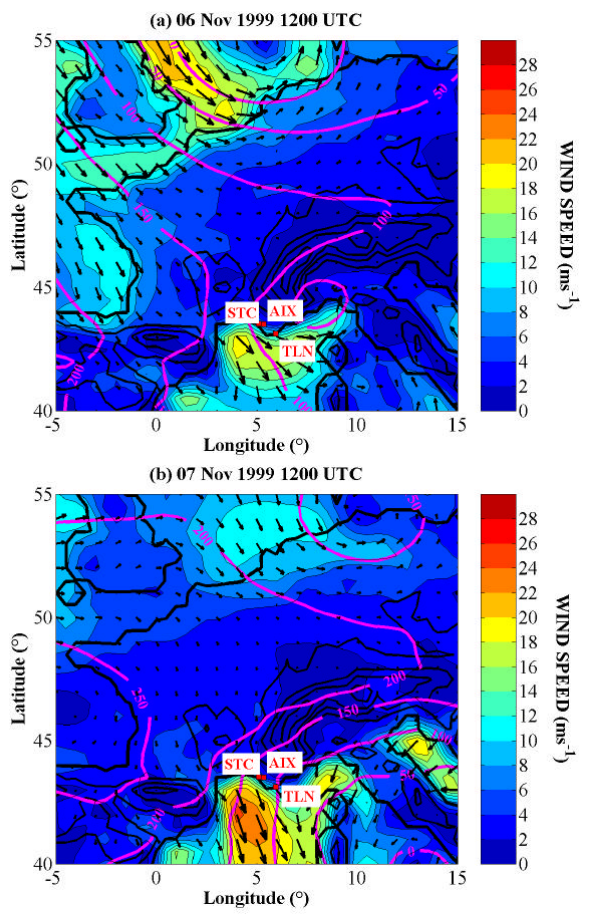
Fig. 1. Map of surface wind and geopotential at 1000hPa above western Europe in a typical Mistral situation from ECMWF-model analyses. The autumn case (see the text) is presented : ( a ) 6 Novem- ber 1999, 12:00 UTC and ( b ) 7 November 1999, 12:00 UTC. The wind speed is indicated in color code and the direction by arrows. The thick and narrow lines show the shore lines and the topography levels every 500m, respectively, used by the model.